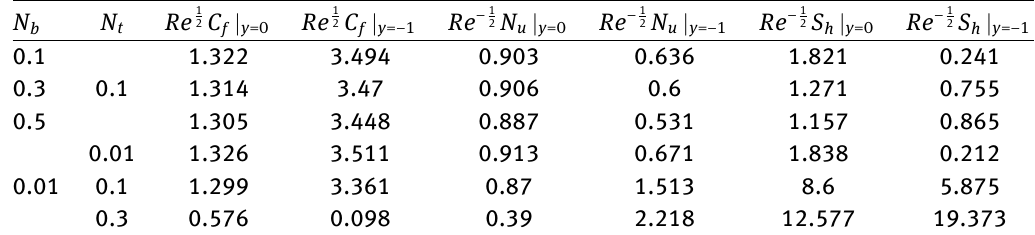
Table 3: Local skin friction coefficient C f , local Nusselt number N u and the local Sherwood S h number for physical parameters N b , N t